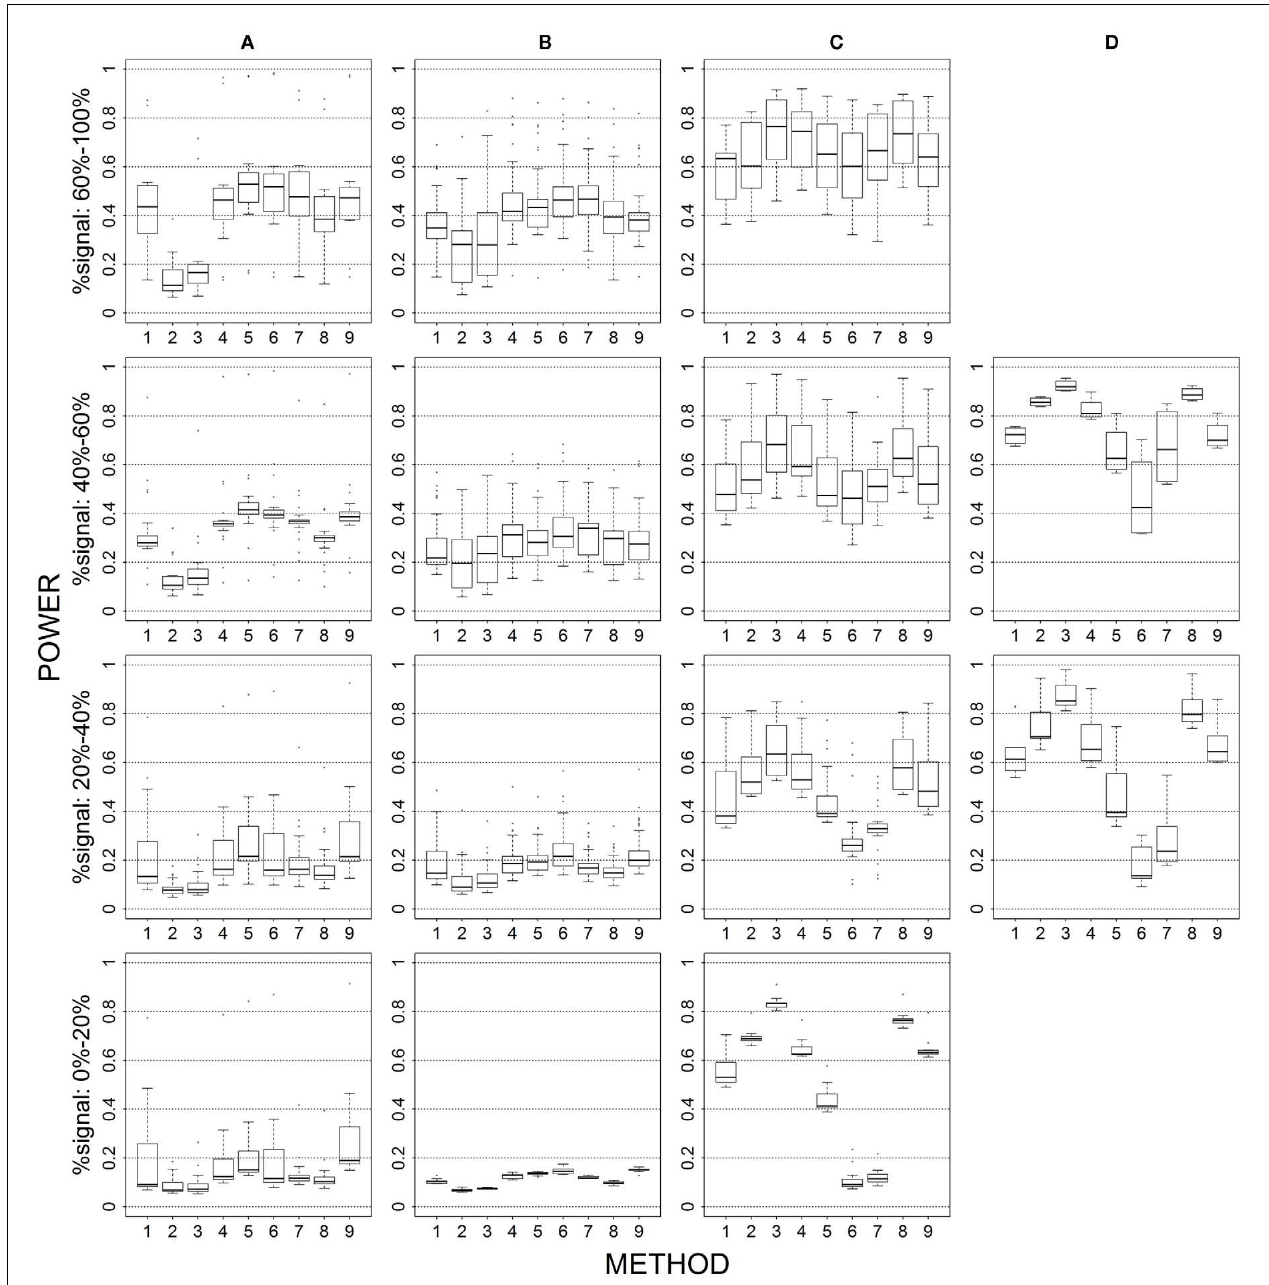
power results for marker-combinations belonging to each average functional allele frequency [ (A) is 0–0.01, (B) is 0.01–0.05, (C) is 0.05–0.10, (D) is